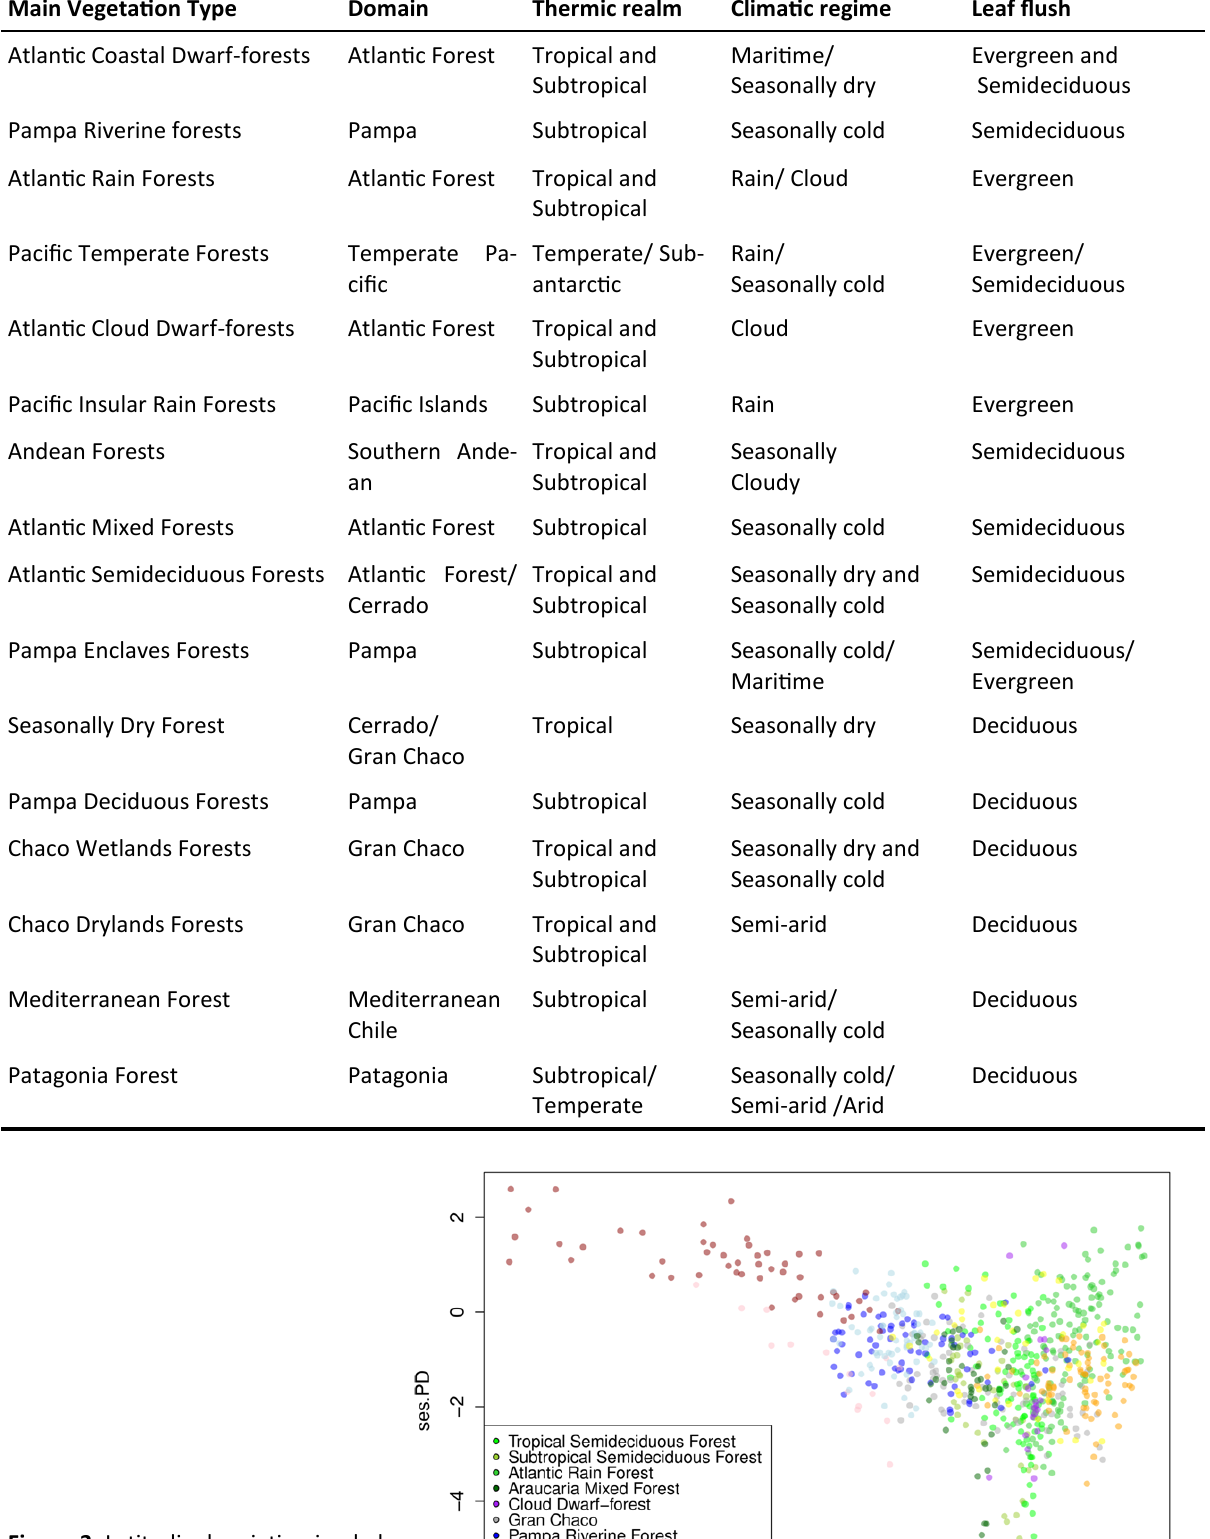
Figure 3. Latitudinal variation in phylo- genetic diversity sensu stricto stand- ardised for variation in species rich- ness (ses.PD). Each point represents the estimated value of ses.PD for a single tree